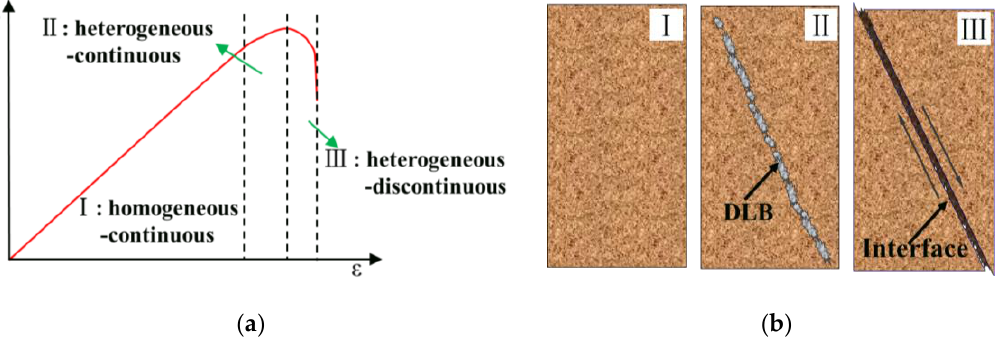
Figure 5. ( a ) Sketches of stress–strain curve; ( b ) structural model.